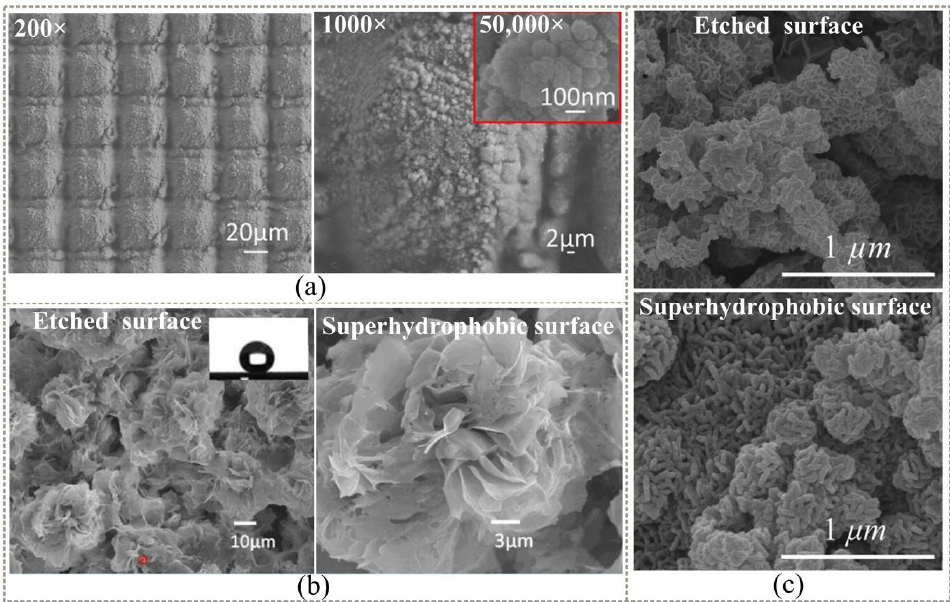
Figure 5. Preparation effects of etching methods: (a) SEM images of a superhydrophobic surface with cross-groove structures [63]; ( b ) SEM images of brass with a superhydrophobic surface [58]; ( c ) SEM images of the original surface, the etched surface, and the superhydrophobic surface [74].